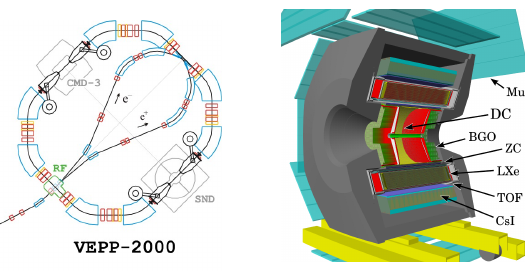
Figure 1. Scheme of the VEPP-2000 collider.